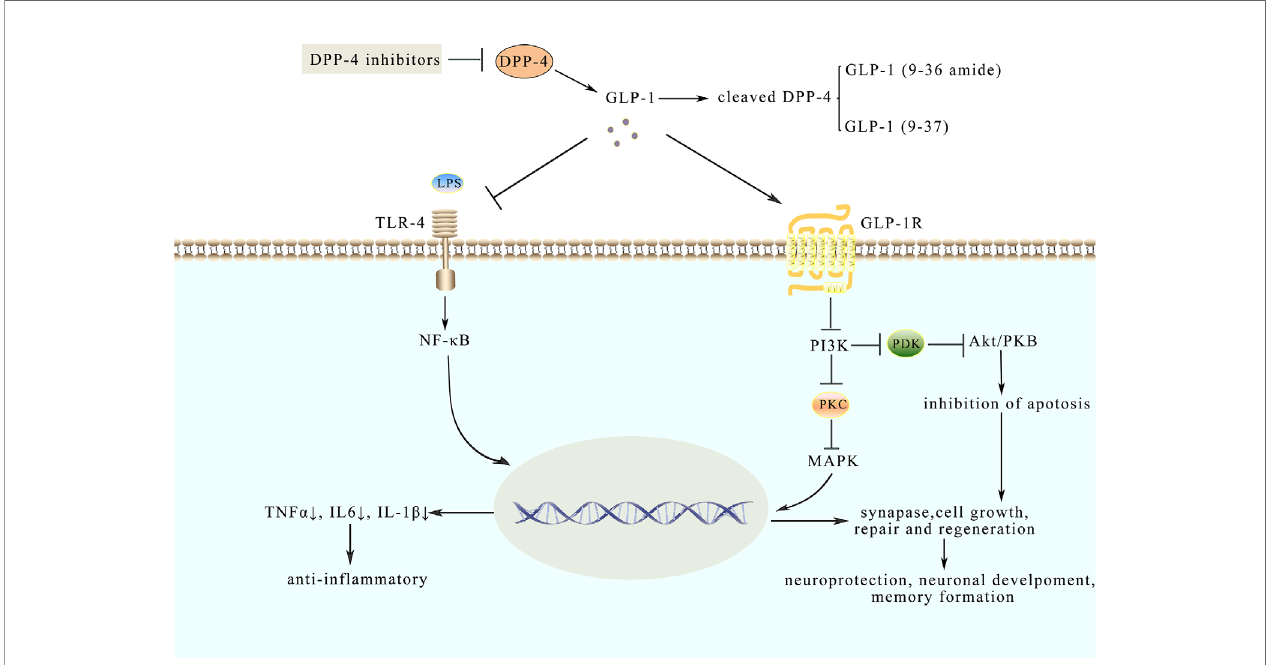
FIGURE 2 | Model diagram of potential mechanisms of neuroprotective and anti-in fl ammatory effects of GLP-1. GLP-1 analogues like native GLP-1 have a longer half-life. Their effects are mediated through binding to GLP-1R, which could inhibit pathways such as the NF- k B pathway and MAPKs pathway. LPS, combined with TLR-4, activates the NF- k B pathway and triggers an in fl ammatory response while GLP-1 could inhibit the response to protect the synaptic plasticity. Besides, GLP-1 binds to GLP-1R to the active AMPK pathway involved in